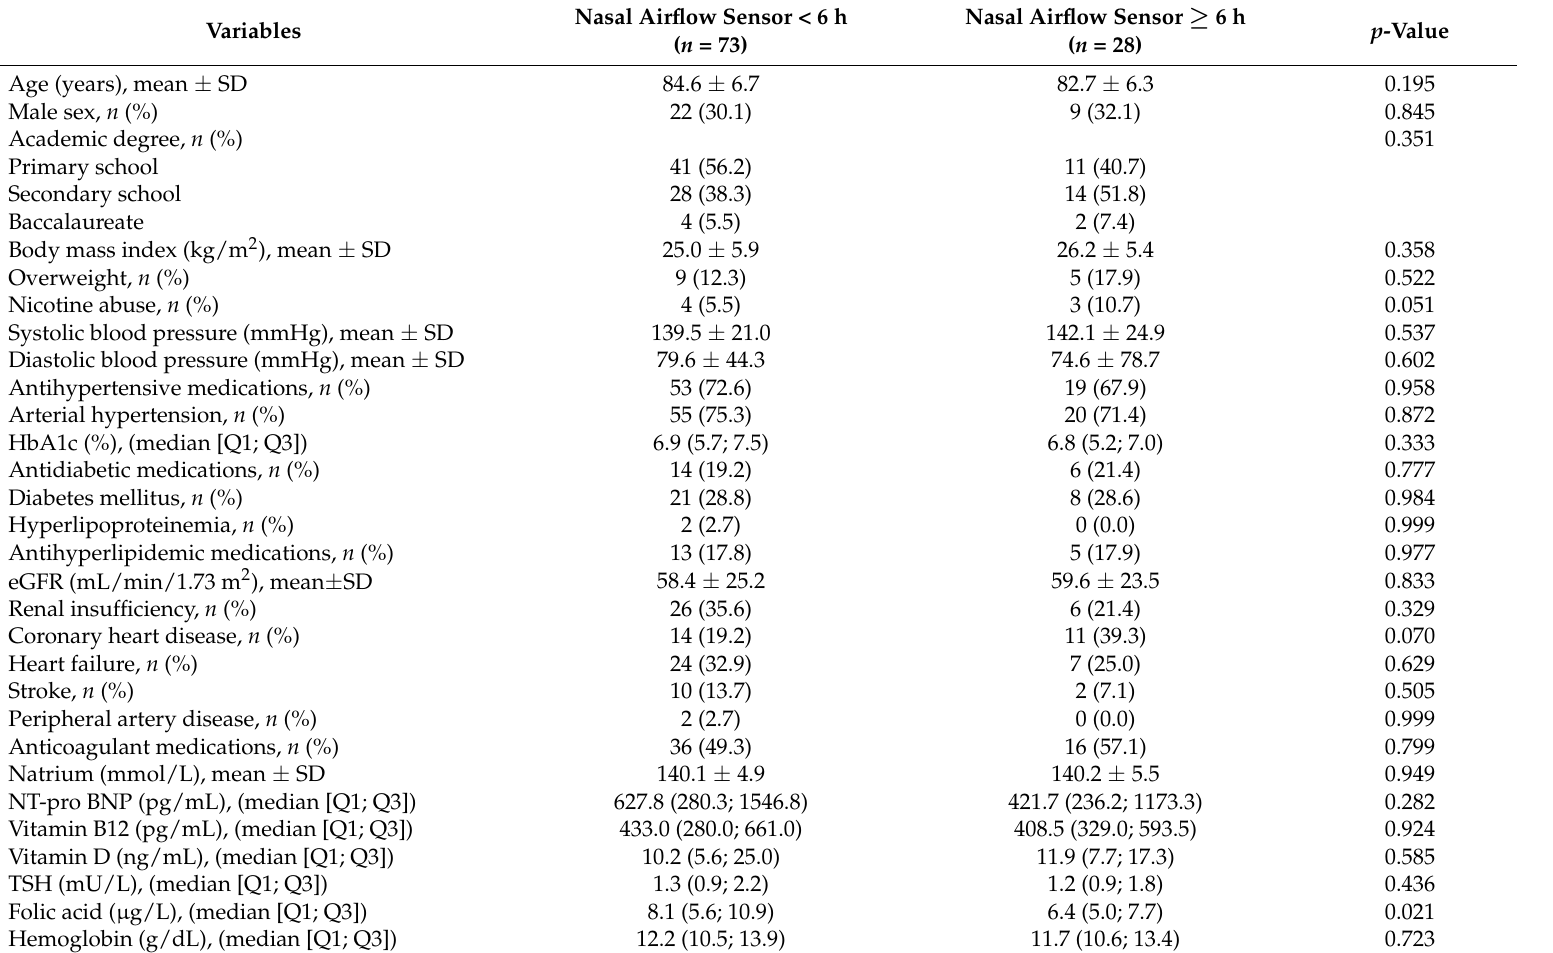
Table 5. Demographic and clinical characteristics split by tolerance of the nasal airflow sensor ≥ 6 h vs. <6